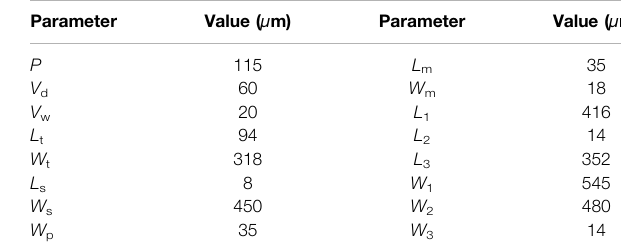
TABLE 1 | Con fi guration parameters of the HMSIW